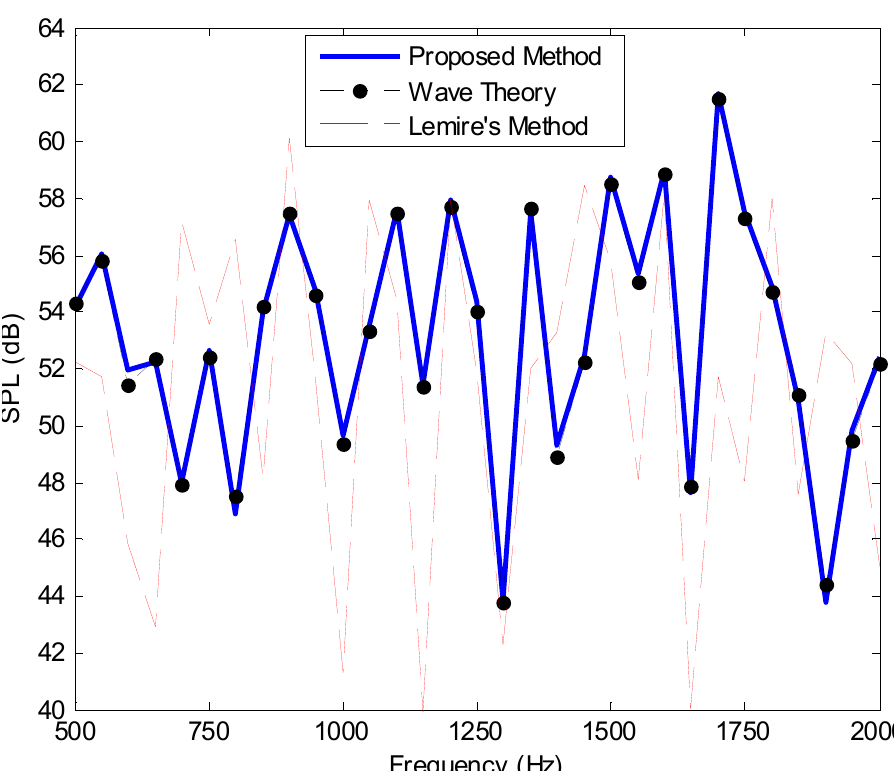
Figure 3. Comparison of predictions on sound pressure level (SPL) spectrum in a long space with 20 m wide and 5 m high in numerical simulations. The source is located at (6 m, 0 m, 1 m), and the receiver is located at (6 m, 50 m, 1 m). The solid line represents the results with the proposed method, the solid circles represent the results with a dot-dash line are those with the wave theory that is considered a benchmark, and the dash line is the result with the method of Lemire and Nicolas (Lemire’s method).